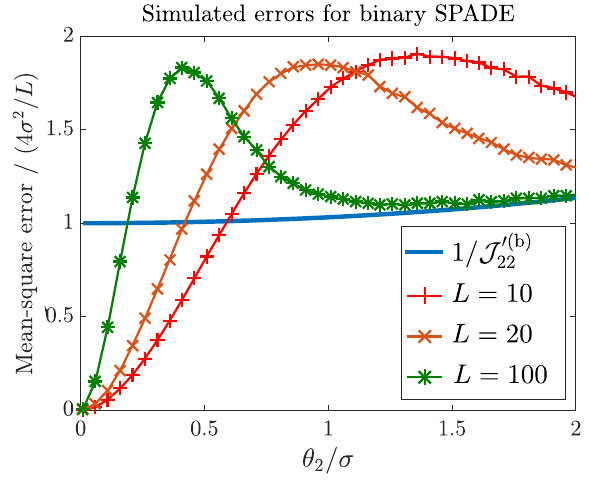
15. Simulated mean-square errors for binary SPADE with maximum-likelihood estimation, conditioned on L detected photons. Note that the vertical axis is normalized with respect to 4 σ 2 =L , so the plotted values are the actual errors magnified by L= ð 4 σ 2 Þ . Each error is computed by averaging 10 5 simulations, and the lines connecting the data points are guides for eyes. ˇ θ 2 σ , the maximum of our considered range of θ set 2 ¼ Figure 15 plots the simulated mean-square errors for binary SPADE with otherwise the same parameters as those for Fig. 14. For small θ 2 = σ , the errors follow very similar trends as their counterparts in Fig. 14, and for larger θ 2 = σ , the errors begin to follow the rising Cramér-Rao bound